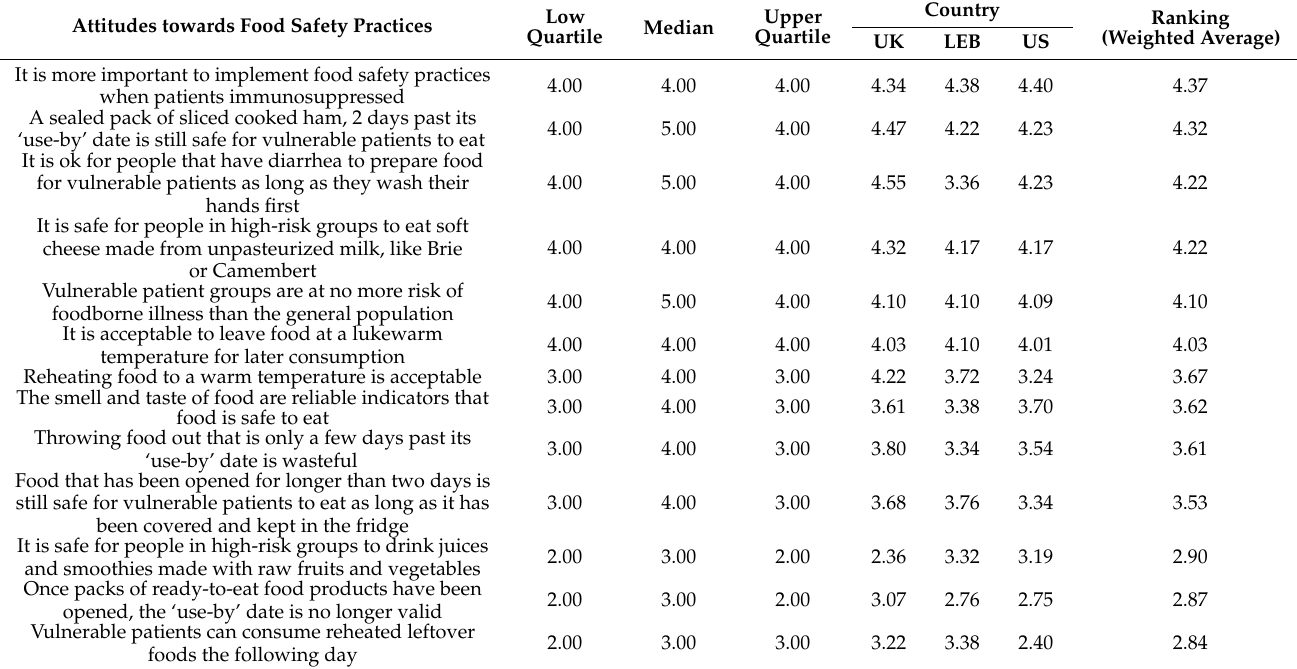
Table 5. Food safety attitudes among students enrolled in dietetics programs in the United Kingdom ( n = 75), Lebanon ( n = 29) and United States ( n =